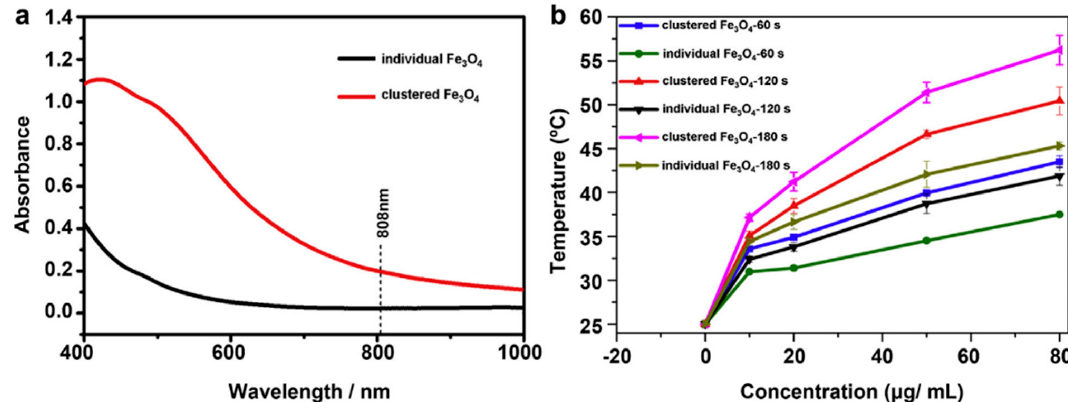
Figure 6. ( a ) Ultraviolet visible (UV-vis) spectra of aqueous dispersion of individual and clustered IONs; ( b ) changes of temperature underwent by the suspensions of individual and clustered IONs (0–80 µg mL − 1 ) after irradiating them for 60–180 s. Reprinted with permission from Biomaterials 39,